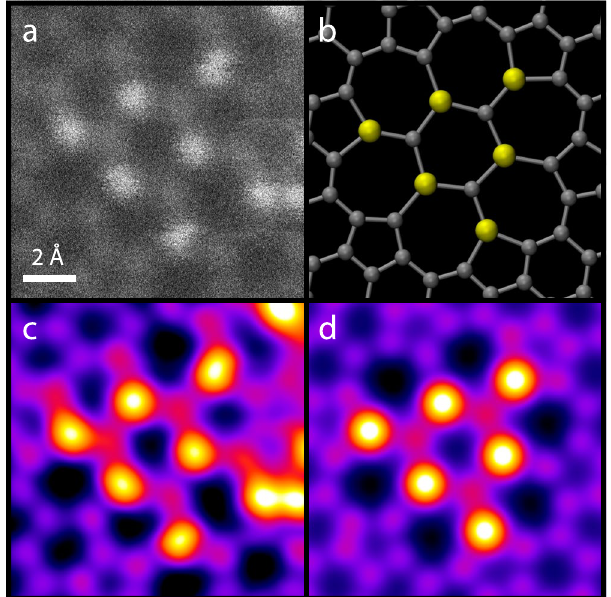
Figure 2. Elemental identification of the atoms within the SiC nanograin. ( a ) Crop of an unprocessed MAADF-STEM image. ( b ) Simplified atomic SiC model. ( c ) The experimental image with noise removed by a Gaussian blur (sigma = 0.28 Å), with higher intensities coloured towards white. ( d ) Crop of a quantitative image simulation of the SiC model (see